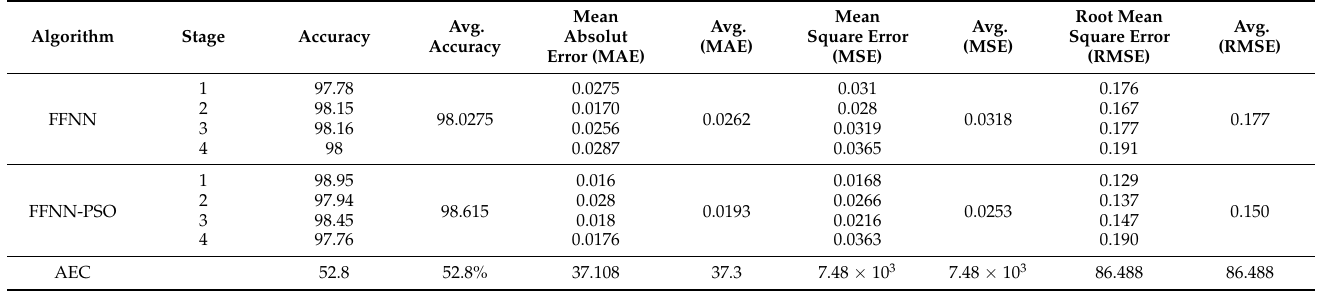
Table 4. The final average results of the performance of the proposed models.